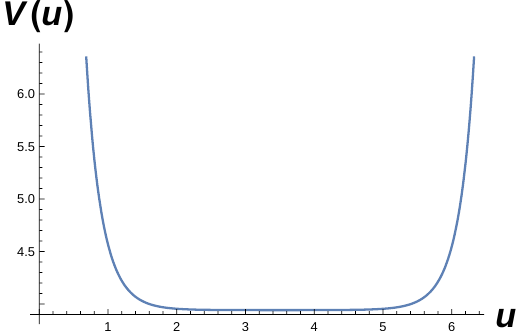
Figure 3. Plot of the potential V ( u ) for one period range.